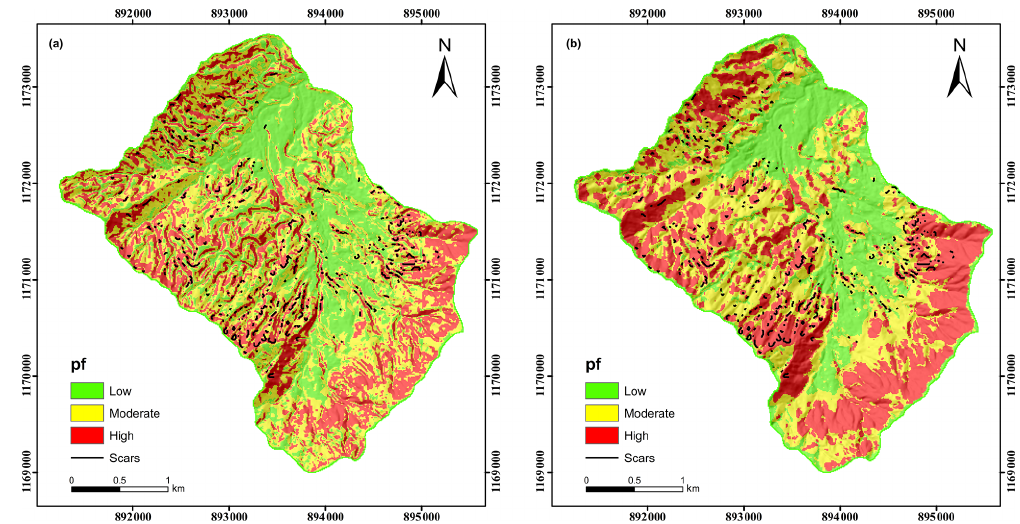
Figure 4. Probability of failure map computed with r.slope.stability. (a) Infinite slope stability model. (b) Ellipsoid-based model.